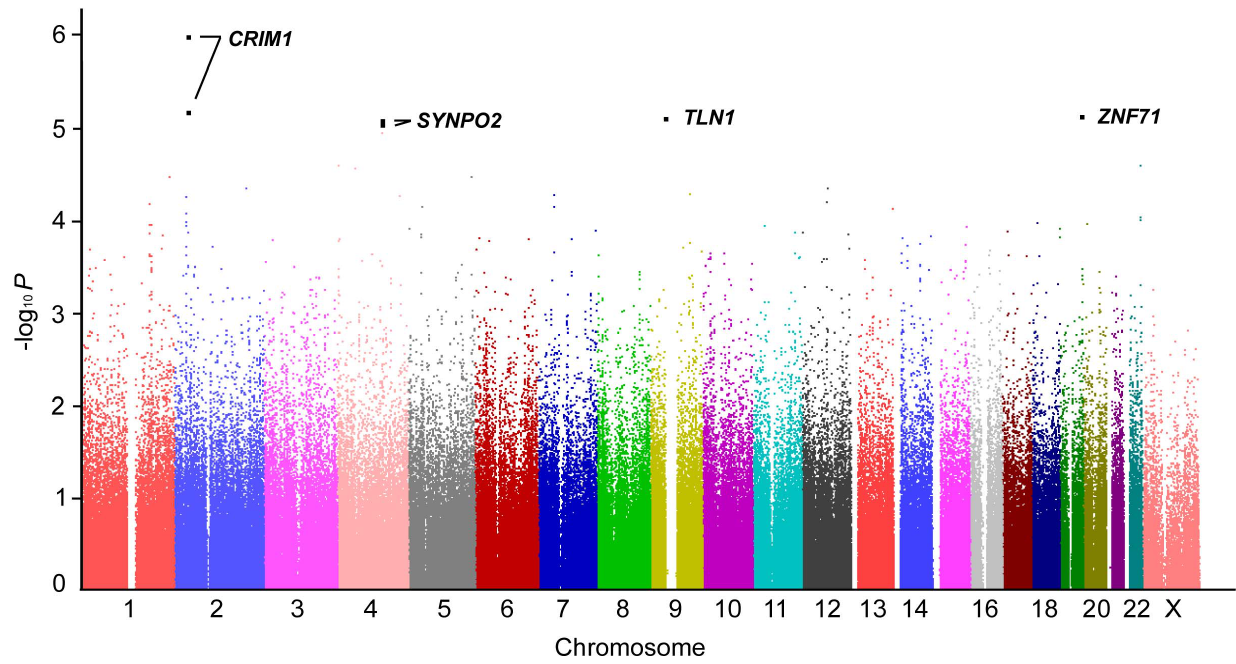
Figure 1. Graphical summary (Manhattan plot) presenting P -values for the association with total serum IgE in asthma patients. The y-axis represents -log 10 P (linear regression analysis) from 442,117 SNPs in 877 patients with asthma, correcting for age, gender, and smoking status as covariates; the x-axis indicates its physical position on successive chromosomes. doi:10.1371/journal.pone.0071958.g001 PLOS ONE |